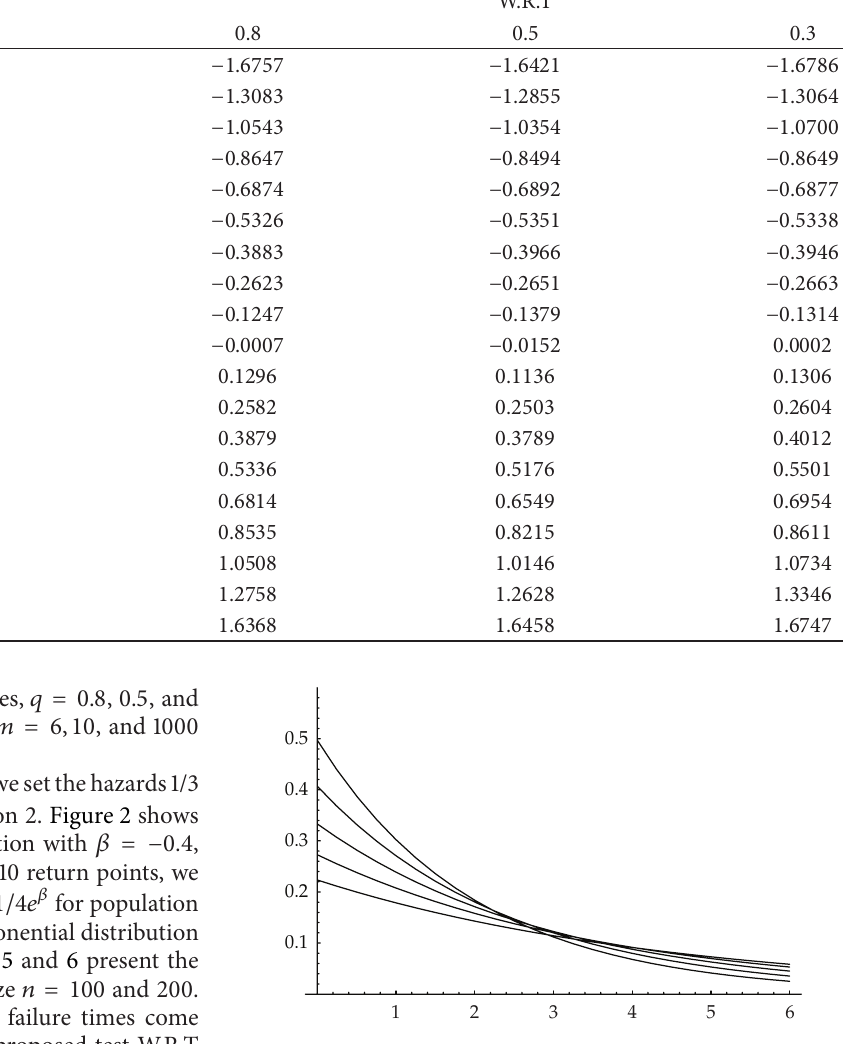
Figure 2: Density plot of exponential distribution with hazards 1/3𝑒 𝛽 .